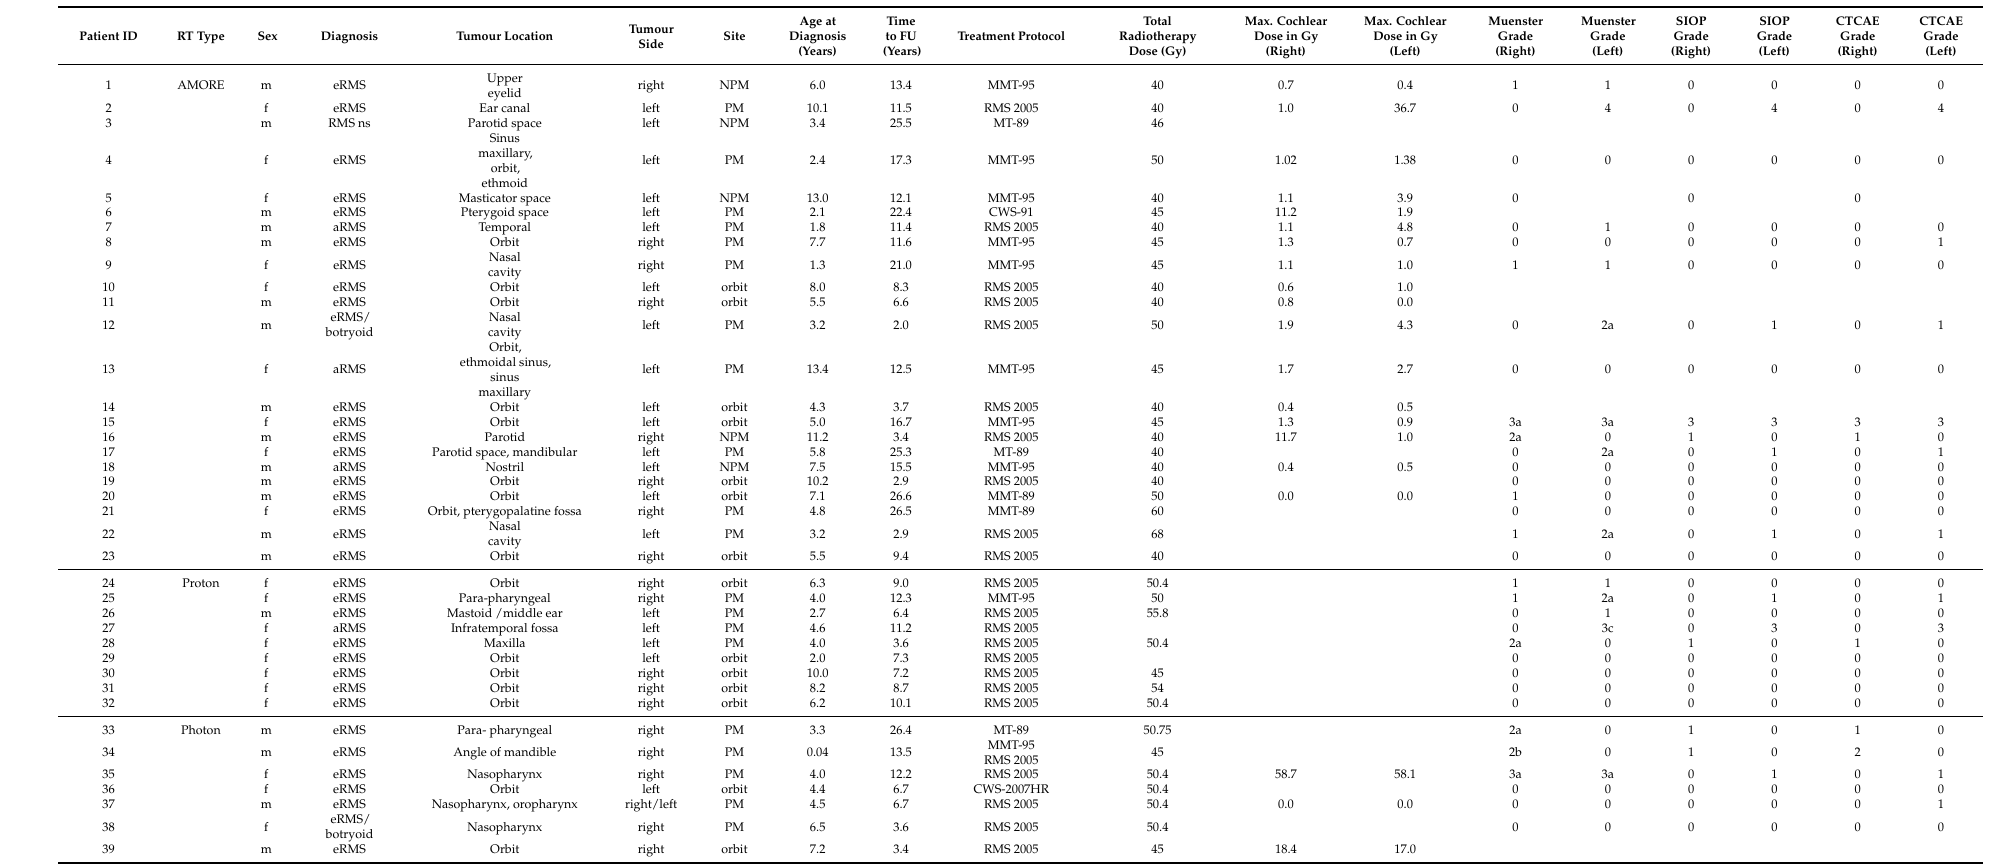
Table 1. Patient characteristics and audiologic